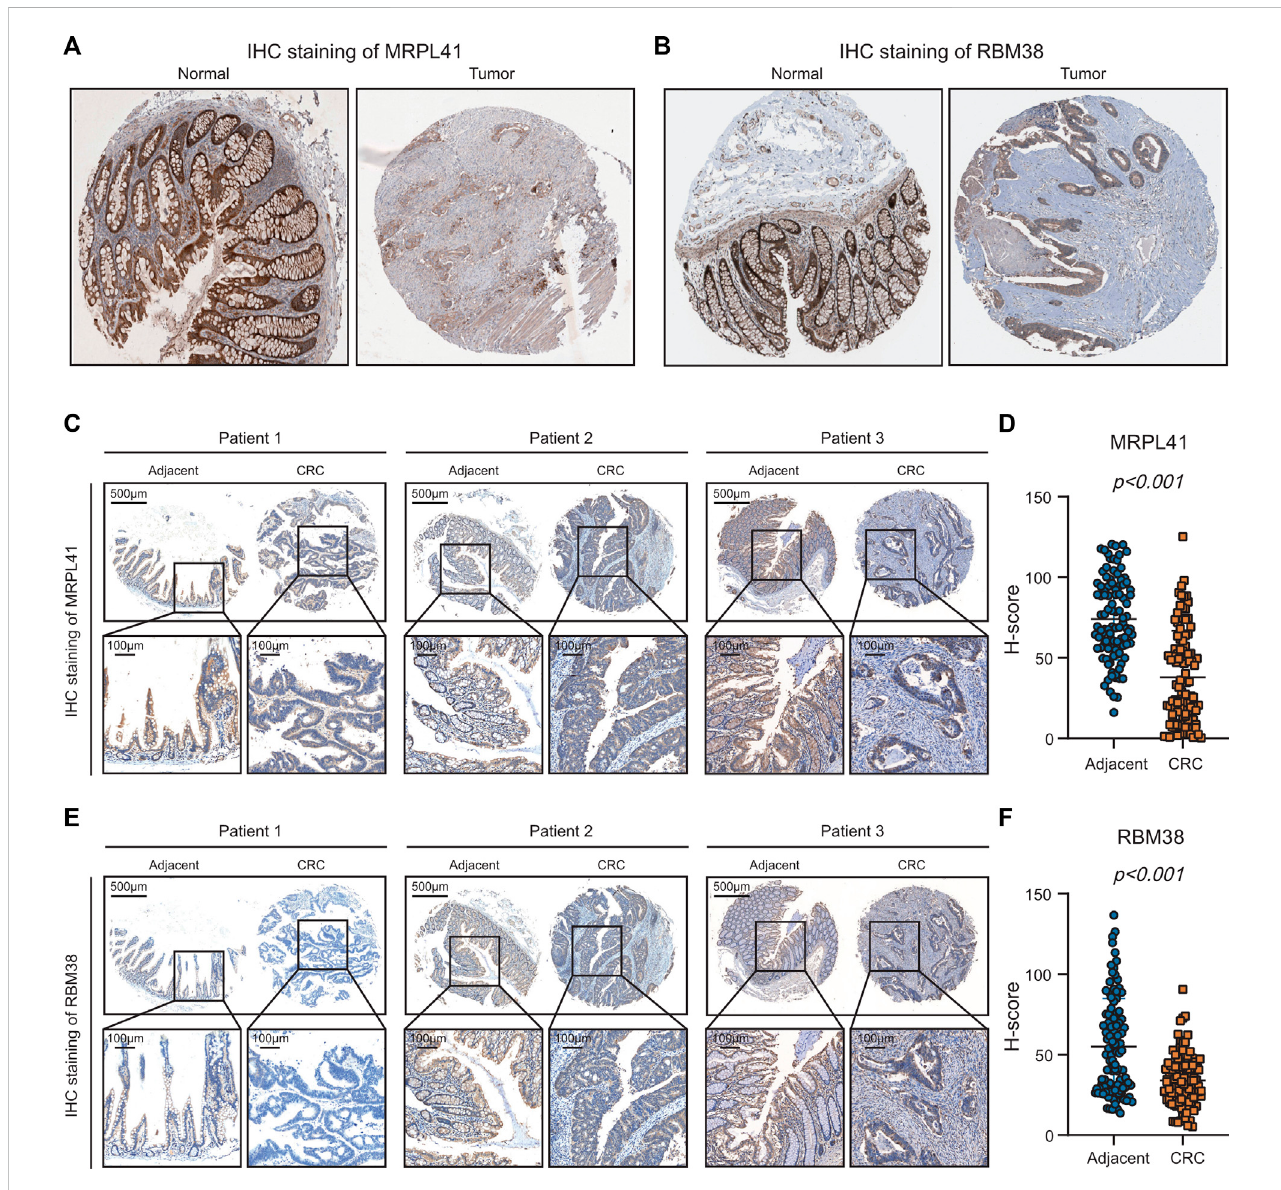
FIGURE 8 ExperimentalvalidationsofMRPL41andRBM38expressionpatterns. (A) RepresentativeIHCstainingimagesofMRPL41retrievedfromtheHPAdatabase. (B) RepresentativeIHCstainingimagesofRBM38downloadedfromtheHPAdatabase. (C) RepresentativeIHCstainingimagesofMRPL41. (D) Thequantitative H-scores of MRPL41 staining. (E) Representative IHC staining images of RBM38. (F) The quantitative H-scores of RBM38